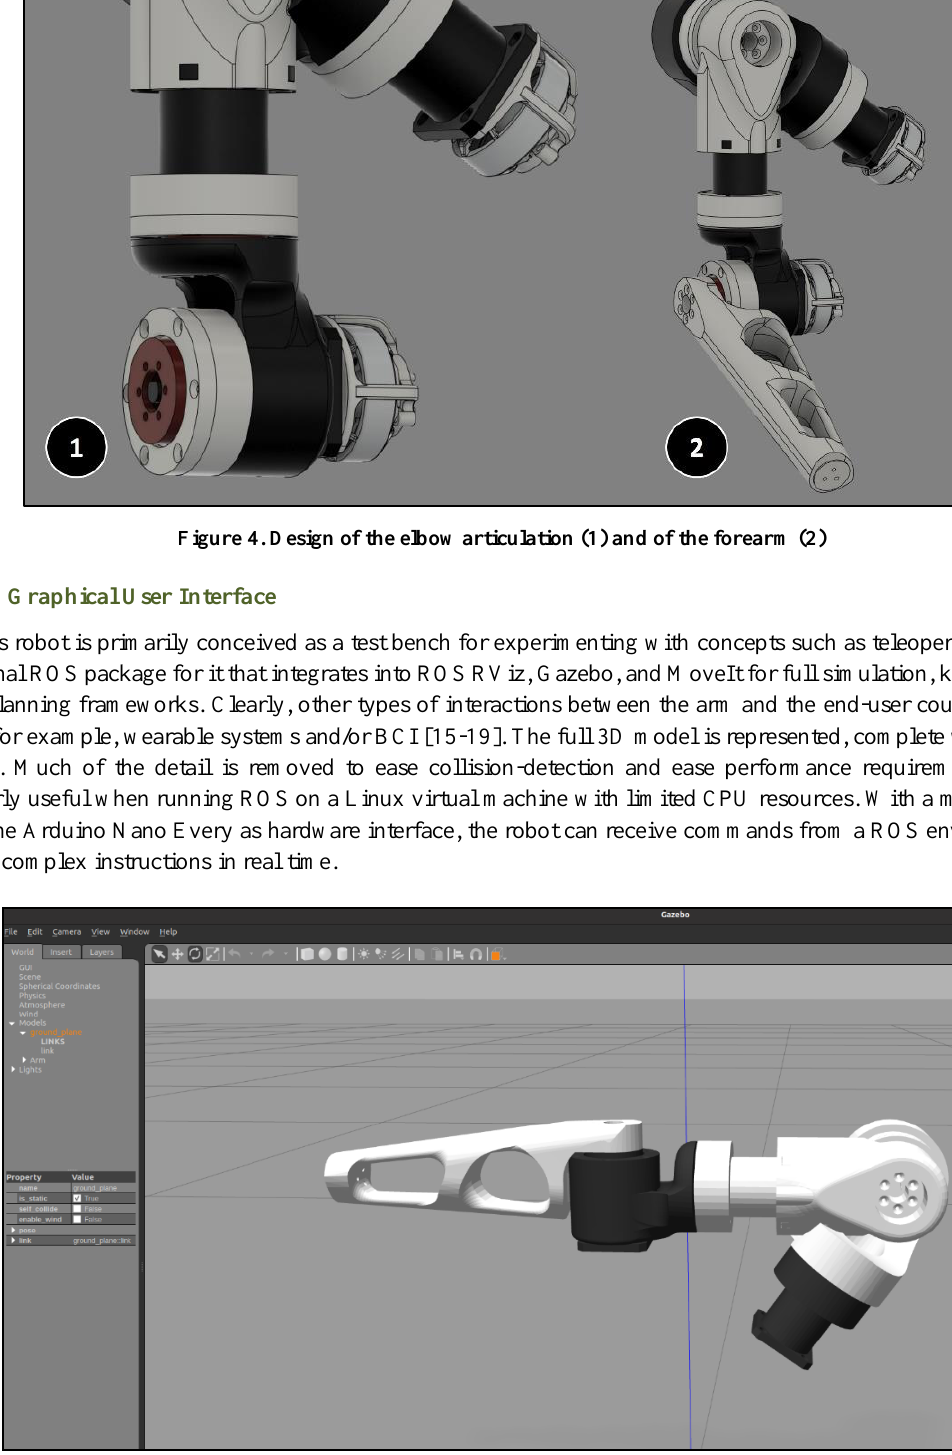
Figure 5. The end-user ROS RViz Gazebo